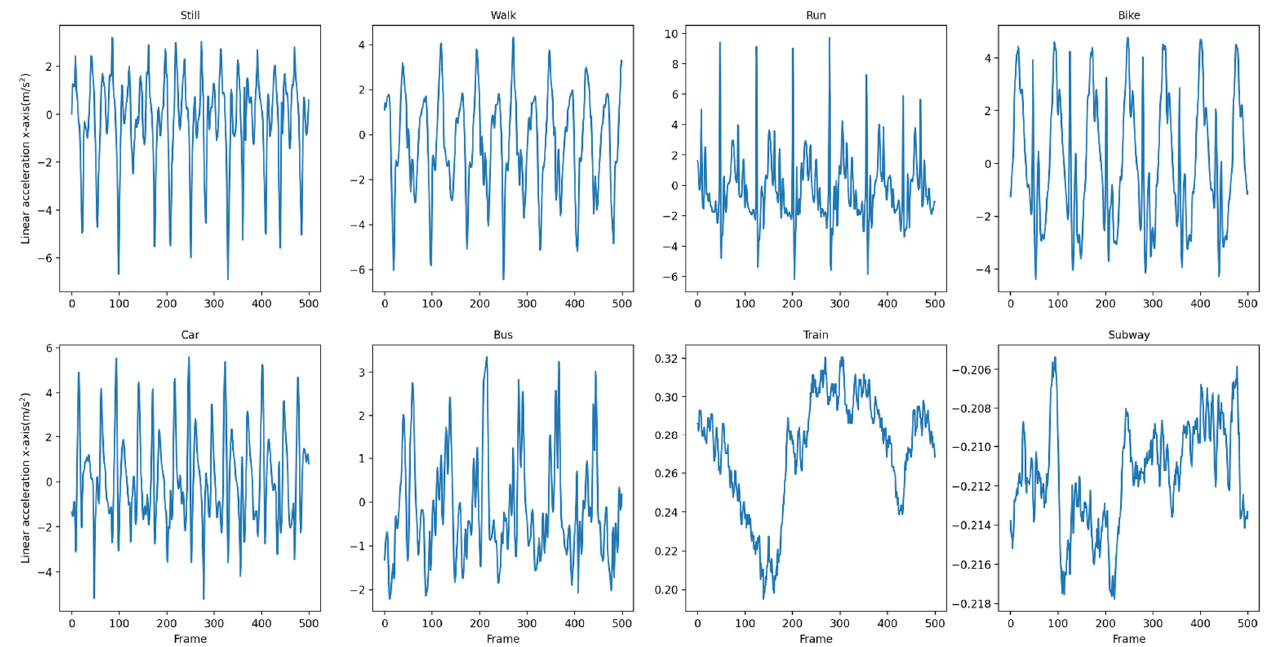
Figure 7. X -axis data for linear acceleration in the SHL dataset.